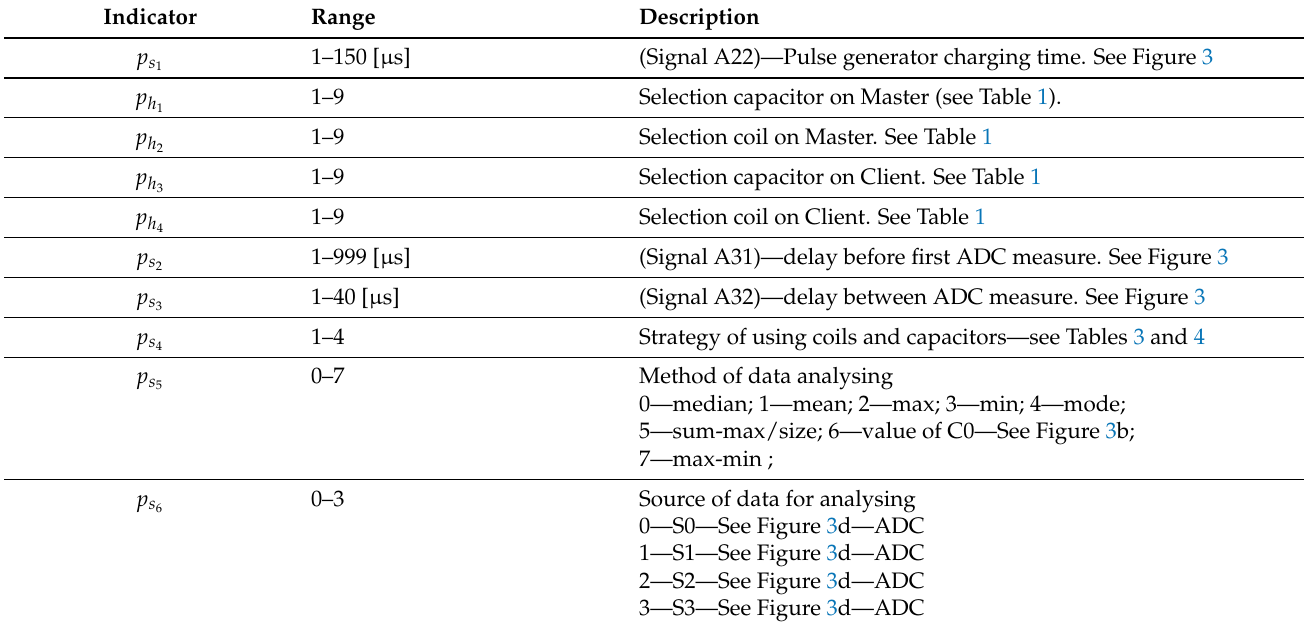
Table 2. A list of decision variables with